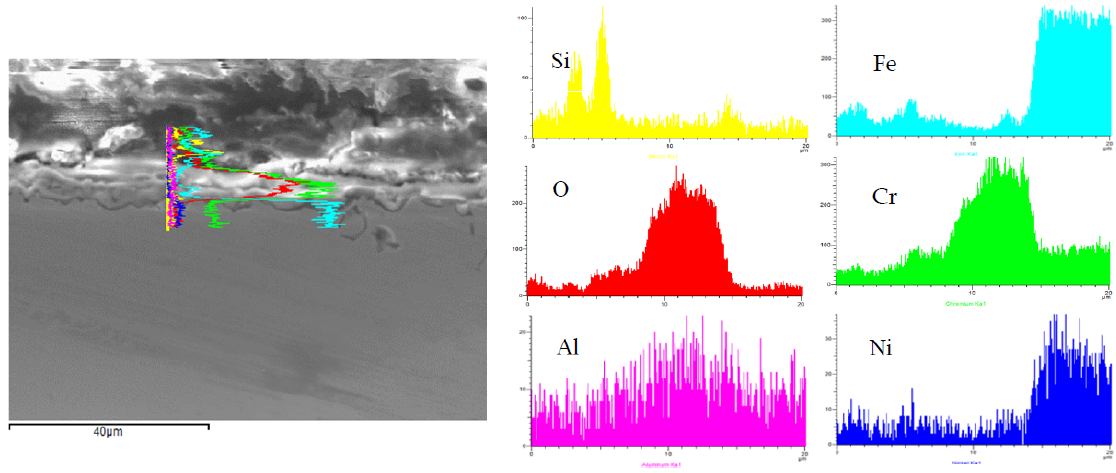
Figure 7. EDS line scanning analysis of stainless steel coated mullite films with three layers after cyclic oxidation.